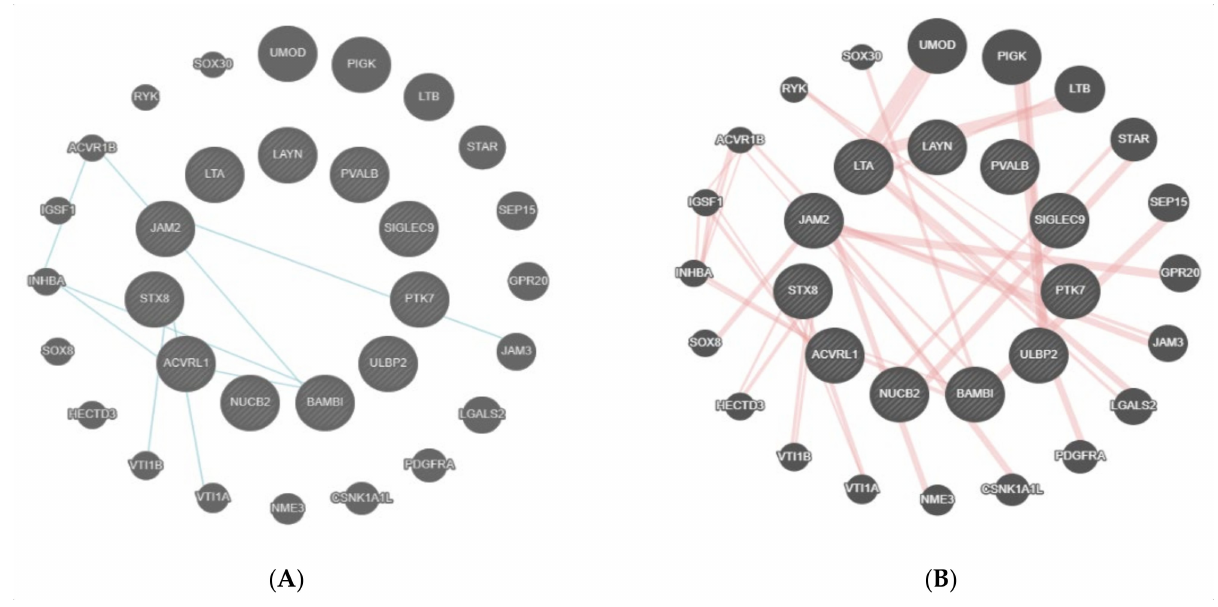
Figure 5. ( A ) shows the physical interaction table for TNF-B, Siglec-9, LAYN, SKR3, JAM-B, N2DL-2, BAMBI, NUCB2, STX8, PTK7, and PVALB. This figure shows the connection between the proteins found in the present analysis (within the circle) and the linked proteins as identified by GeneMania. The 11 central proteins were identified in the present study. All of the other encircled proteins in the periphery linked with blue lines to the central proteins are the ones with a relevant physical interaction with the latter. Interaction of proteins is visualized by blue lines. ( B ) shows pathway interactions for TNF-B, Siglec-9, LAYN, SKR3, JAM-B, N2DL-2, BAMBI, NUCB2, STX8, PTK7, and PVALB. The 11 proteins in the middle were found in the present study. The circulated proteins were identified as linked to the proteins of the present study, which is shown by the red